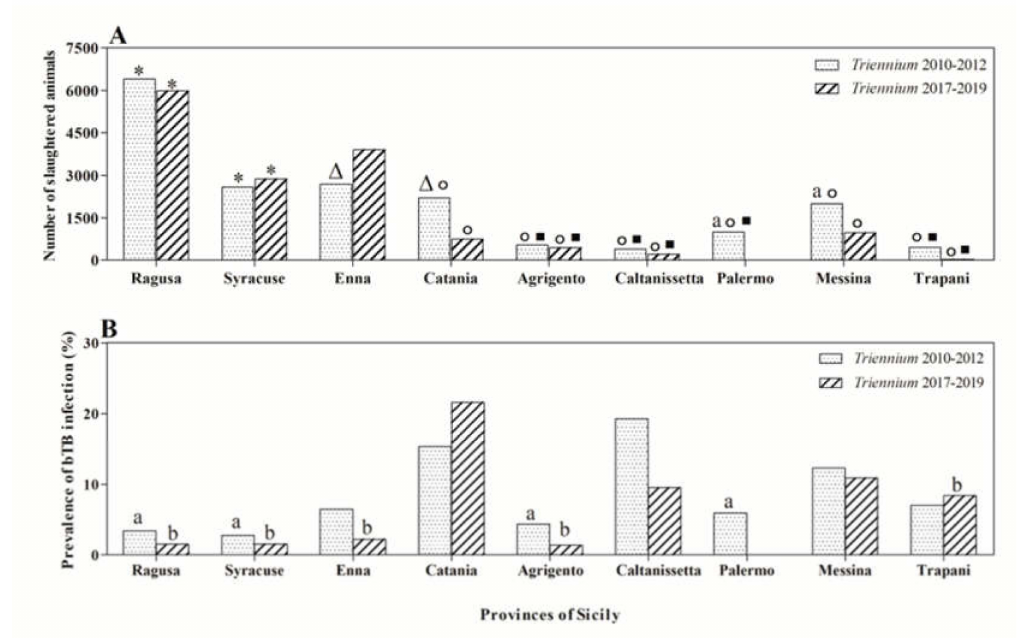
Figure2. NumberofslaughteredanimalsperprovinceofSicily( A )andprevalenceofbovinetuberculosis (bTB) ( B ) during the triennia 2010–2012 and 2017–2019 with the related statistical significances found. Statistical significances: ∆ vs. Triennium 2017–2019 ( p < 0.01); * vs. all the other provinces ( p < 0.001); ◦ vs. Enna ( p < 0.01); (cid:3) vs. Catania and Messina ( p < 0.01); a vs. Caltanissetta ( Triennium 2010–2012, p < 0.05); b vs. Catania ( Triennium 2017–2019, p <